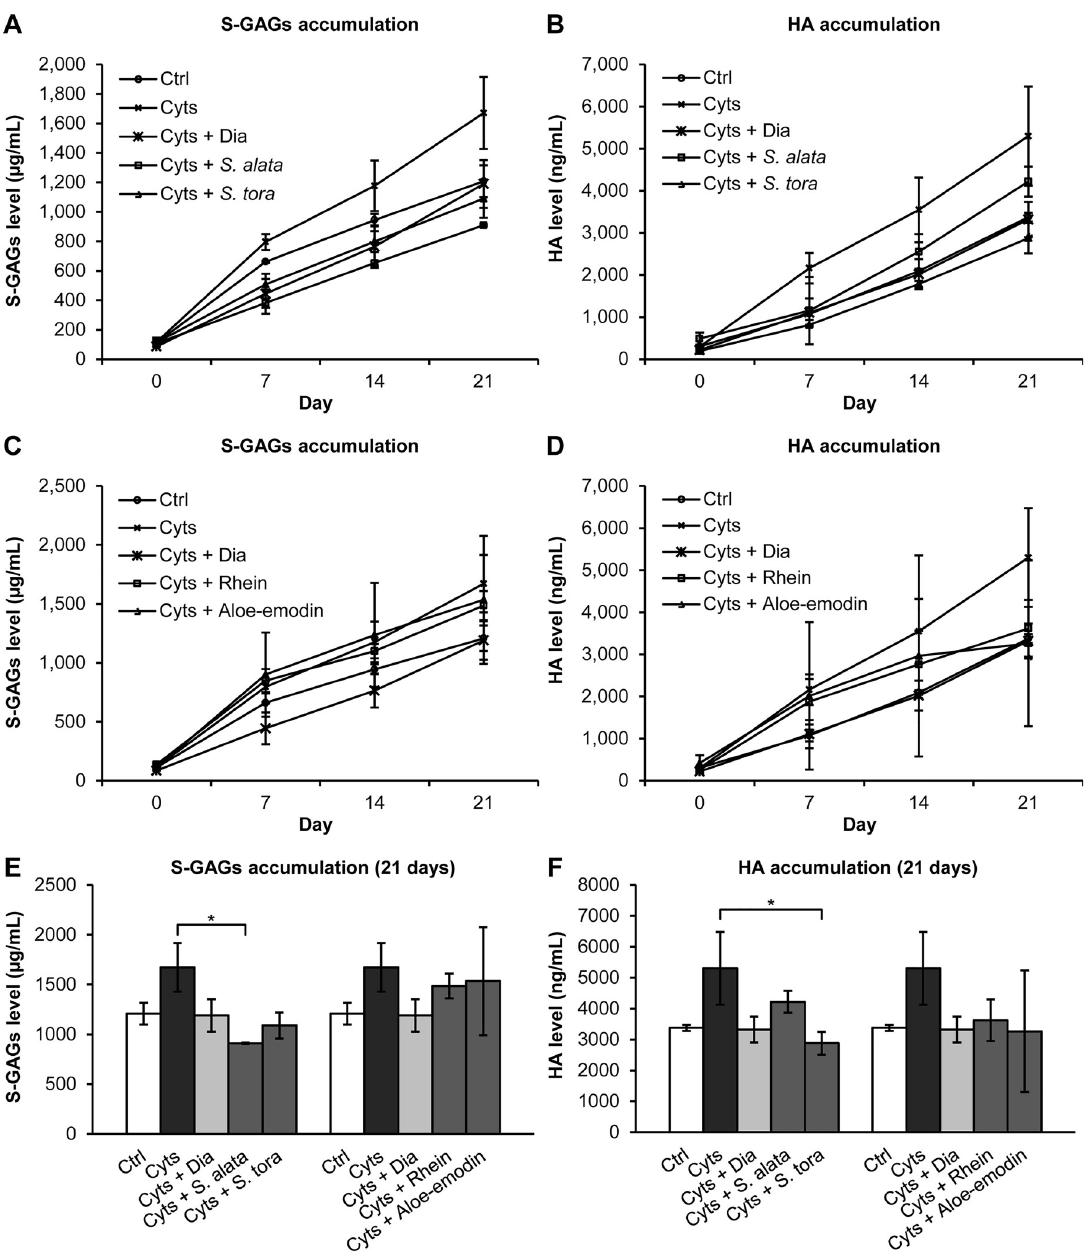
Fig 5. Cumulative release of S-GAGs and HA in the media of the long-term cartilage explant culture. Accumulative values were determined through the sum of the measured S-GAGs or HA levels at each time point and at the previous time point (A–D). Graphs E and F represent the total release of S-GAGs and HA from 21 days of the long-term treatments, respectively. The results are expressed as mean ± SD of triplicate experiments. The asterisk ( � ) indicates a significant difference at p < 0.05. Cyts: the combined cytokines (2 ng/ mL IL-1 β and 4 ng/mL IL-17A); Ctrl: control (untreated